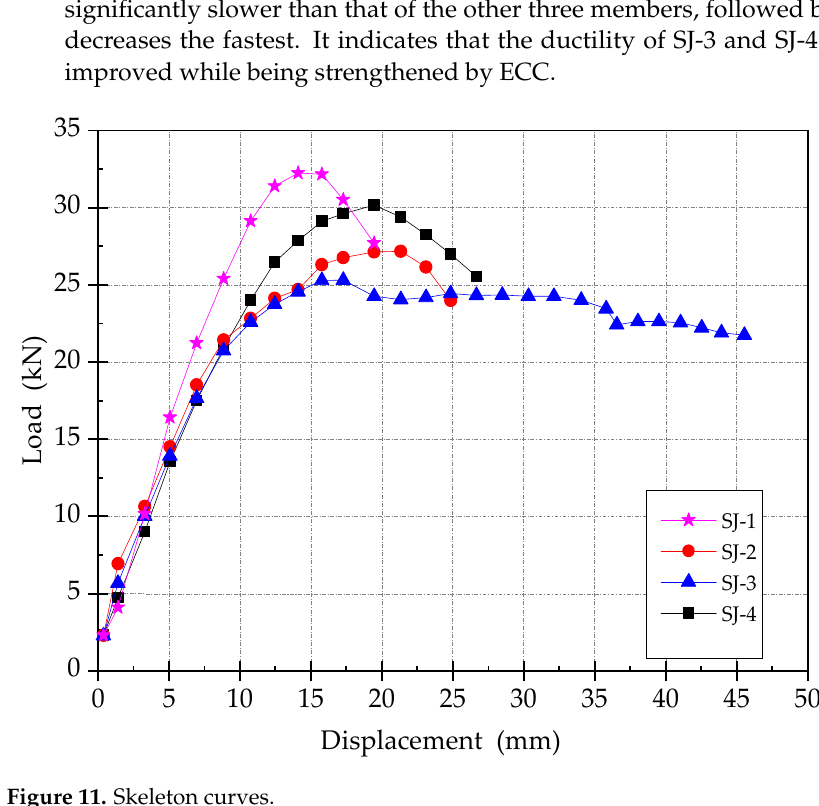
Figure 11. Skeleton curves.